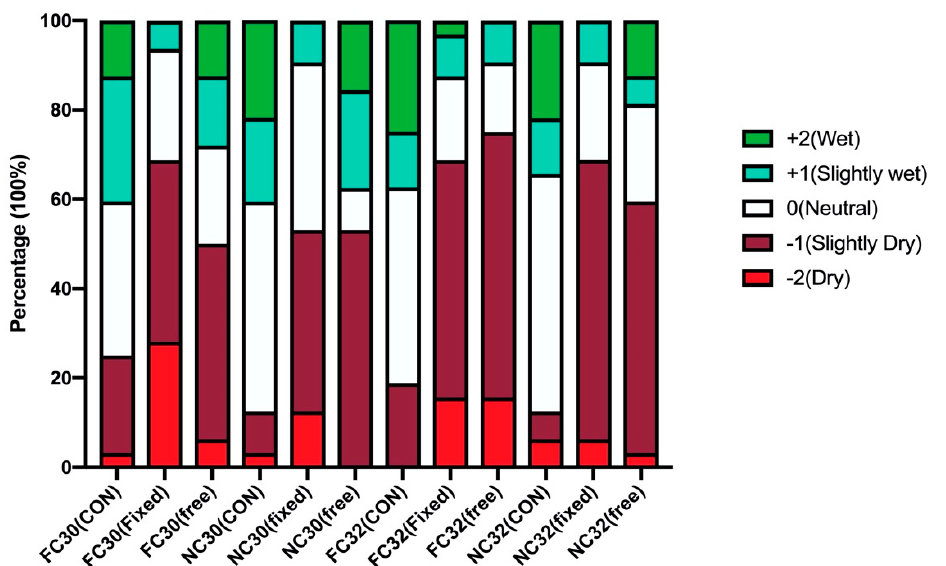
Figure 6. Ratings of dry eye symptoms in the 12 tested scenarios.